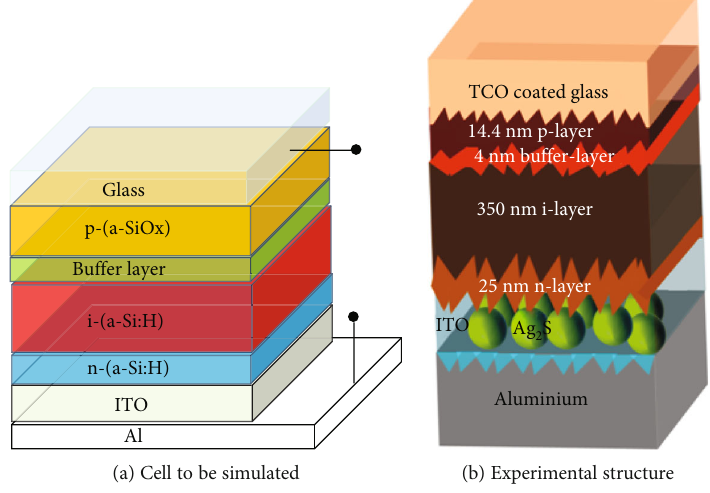
Figure 1: Schematic diagram of solar